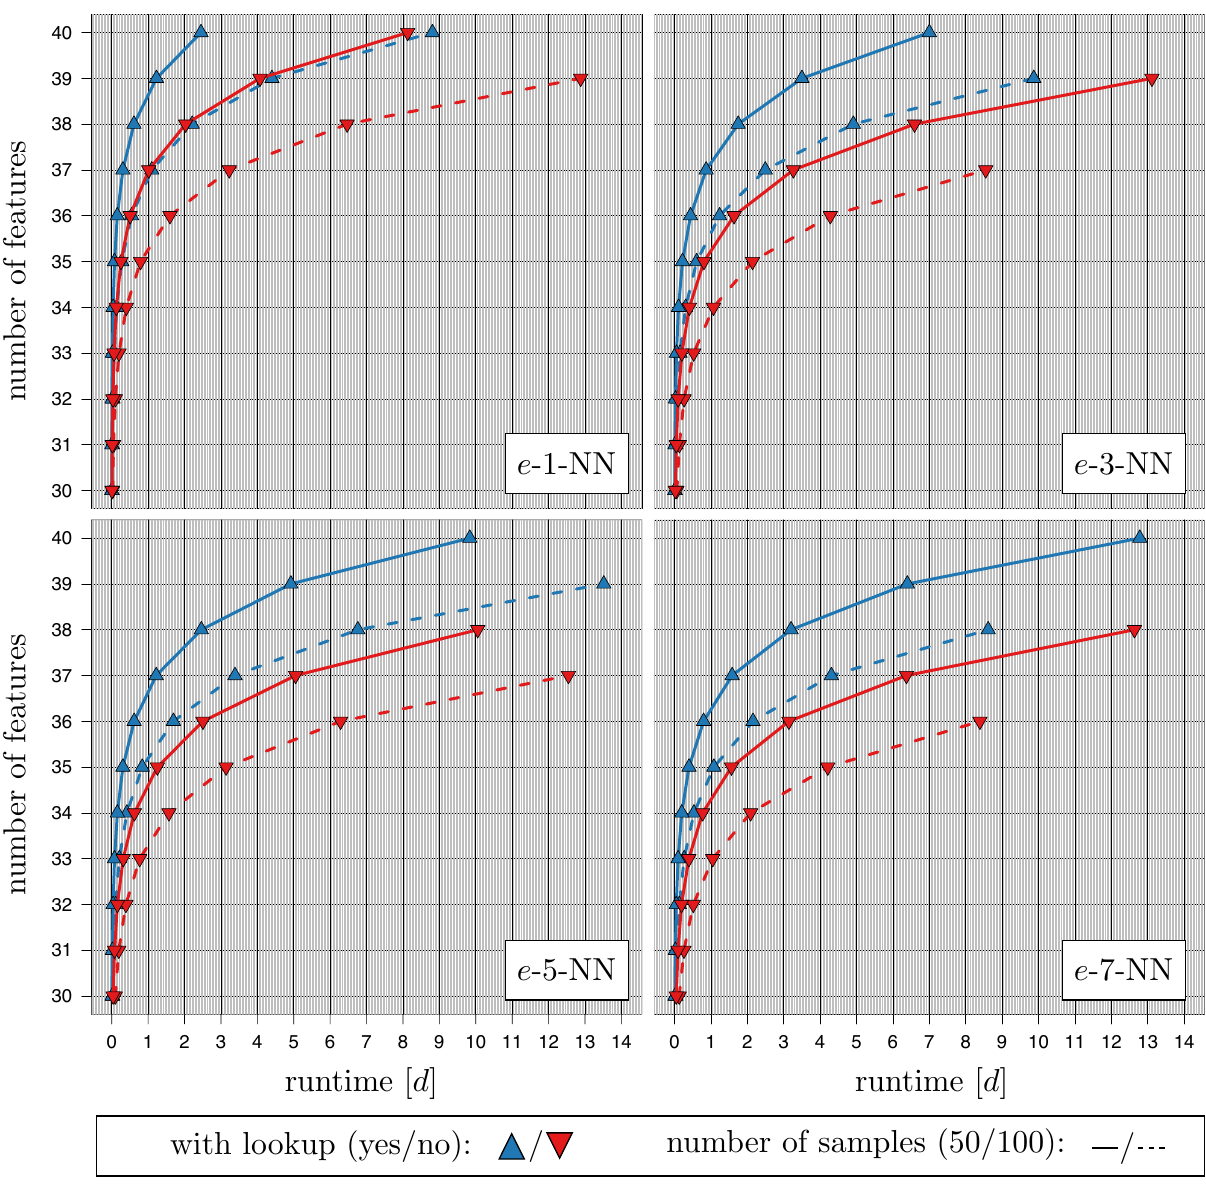
Figure 5. Runtime experiments with e - k -NN. The figure shows the runtime of experiments with e - k -NN ( k ∈ { 1, 3, 5, 7 } , 100 cores) on artificial datasets with m ∈ { 50, 100 } samples. Each feature combination was evaluated in a 10 × 10 CV experiment. A maximal runtime limit of 14 days ( ≈ 1.21 · 10 9 ms) was used. The runtime of e - k -NN with and without lookups (upper-blue/lower-red triangle) on artificial datasets with varying dimensionality n ∈ { 30, . . . , 40 } is